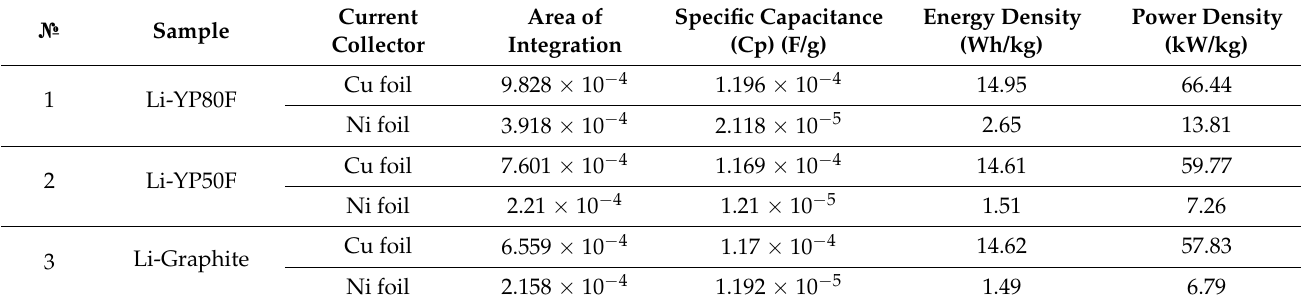
Table 3. The area, specific capacitance, energy density and power density calculation of each electrode from CV